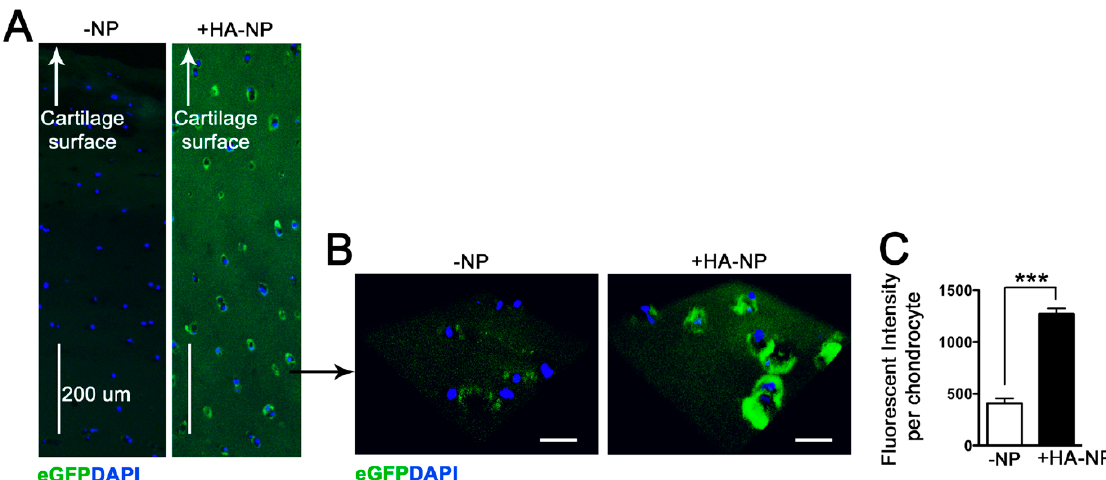
Figure 4. HA-coated p5RHH-eGFP mRNA NPs at 1 µ g of mRNA and 10 µ mol of p5RHH were incubated with 5 mm 2 cartilage discs derived from human OA knee joints. After 48 h, cartilage explants were washed, processed, and examined for eGFP expression (green). ( A ) eGFP expression was detected in all layers of cartilage. ( B ) Higher magnification revealed eGFP expression in chondrocytes residing in the deep zone of cartilage. DAPI stains nuclei blue. Scale bar = 25 µ m. ( C ) Mean eGFP fluorescent intensity ± SEM per chondrocyte (n = 20 chondrocytes assessed per treatment condition). N = 3 cartilage discs per treatment. Scale bar = 25 µ m, *** p < 0.001.